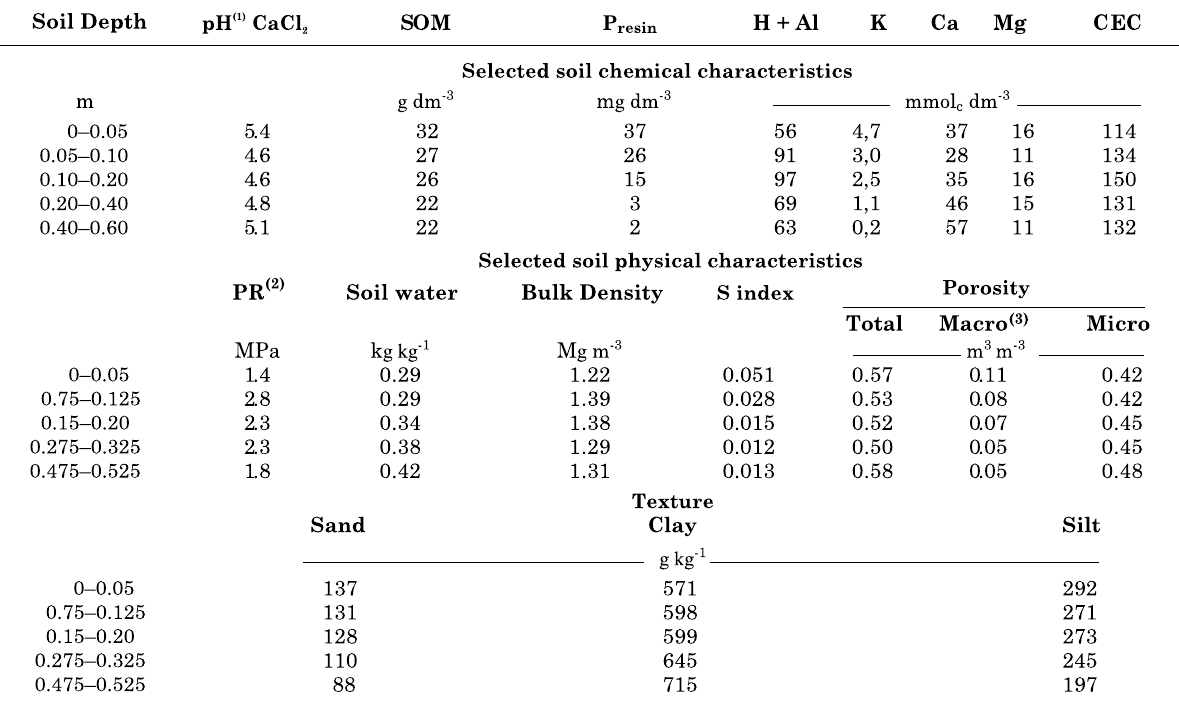
Table 1. Selected chemical and physical properties of the Rhodic Nitosol at the beginning of the experiment